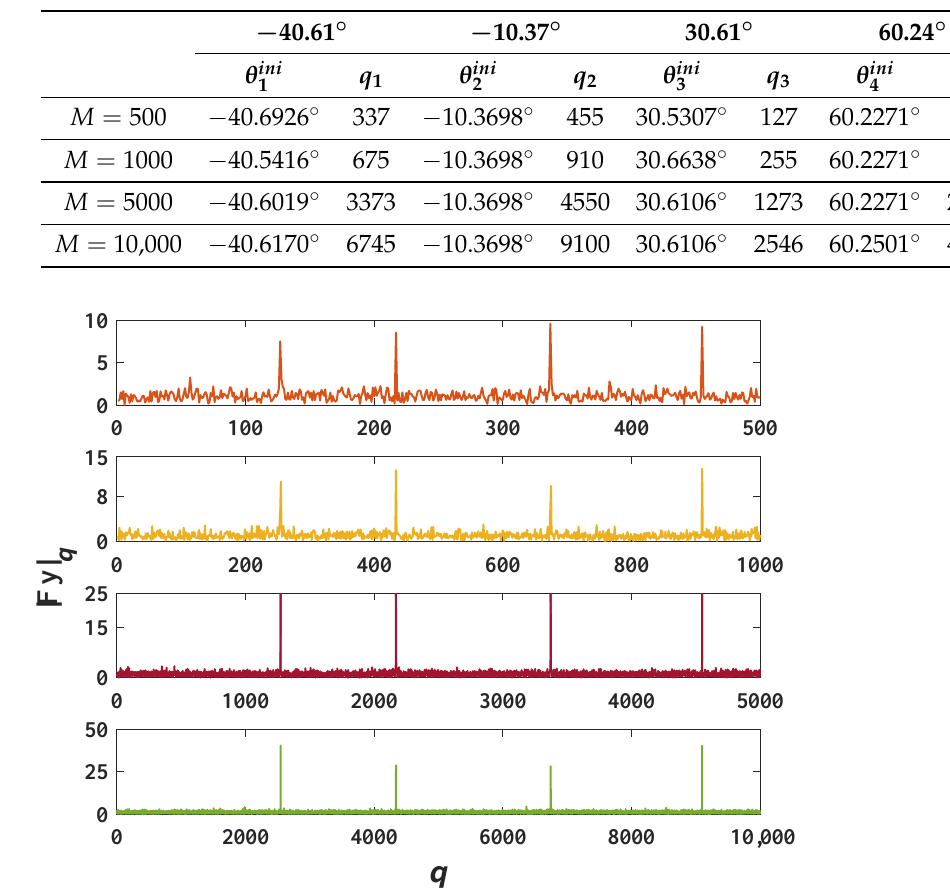
Table 1. Peak location and initial DOA estimation.